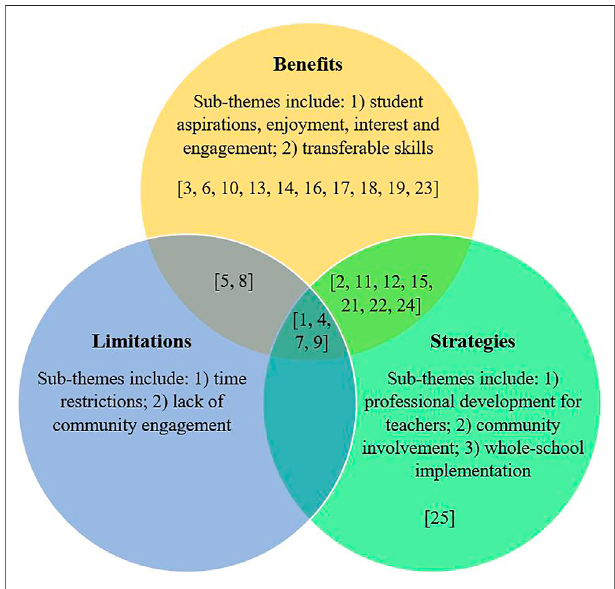
FIGURE 2 | Overarching themes emerging from the studies (numbes refer to Supplementary Table S1 in Supplementary Metrial).